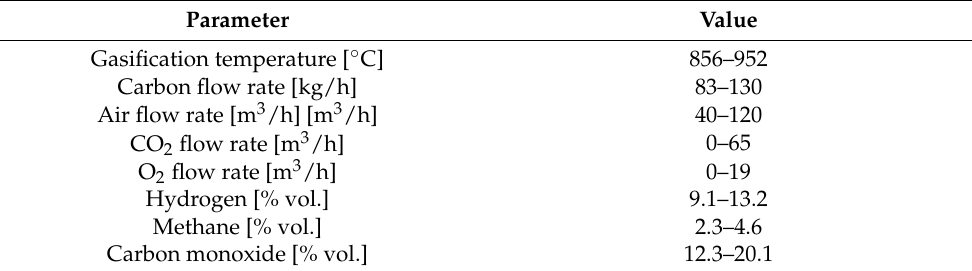
Table 3. Gasification process parameters and the content of combustible components in the process gases [50].